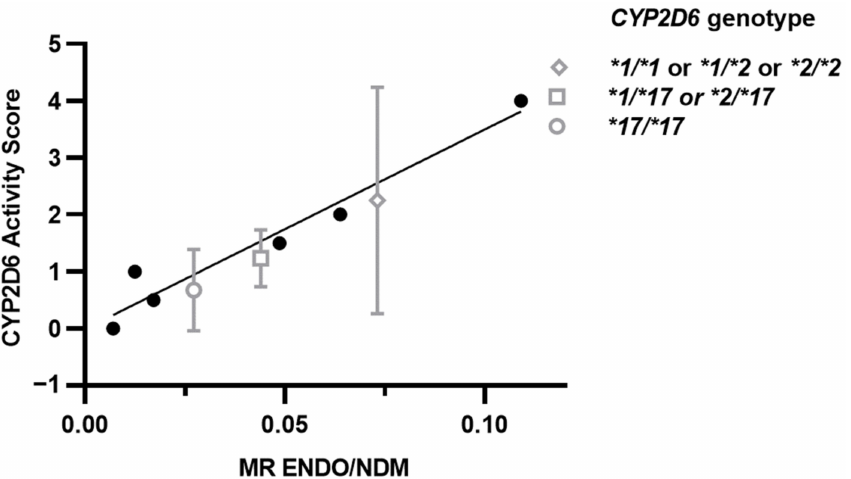
Figure 3. CYP2D6 activity calibration curve plotted as observed MR [12] vs. activity score obtained from the CPIC guidelines [32]. The interpolated predicted activity scores for the three arms are presented on the graph as the median and interquartile range (IQR). The predicted activity score for our study is shown in grey for CYP2D6*1 or *2, CYP2D6*1/*17 or *2/*17, and CYP2D6*17/*17. Predicted activity scores on the y axis were based on the current CPIC guidelines.